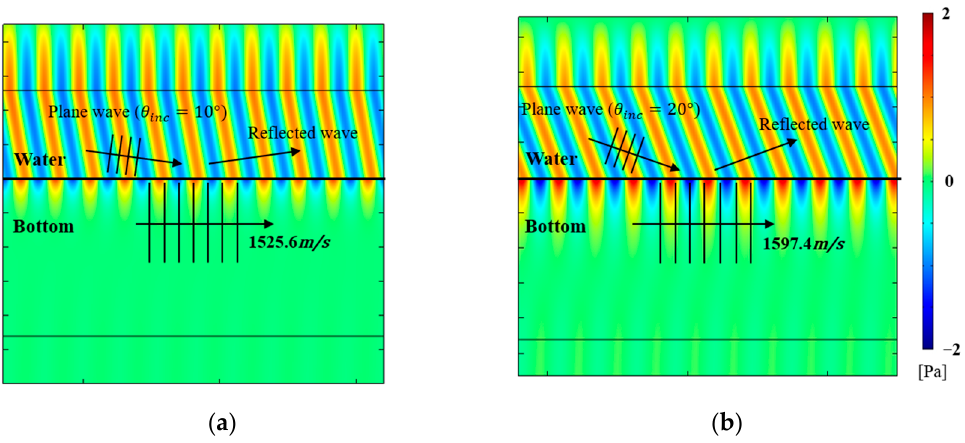
Figure 2. Penetrating waves simulated using FEM for incident plane waves with incident angles of ( a ) 10 ◦ and ( b ) 20 ◦ . The penetrating waves propagates horizontally in the sediment with sound speeds depending on the incident angles and diminish with an increment of depth.